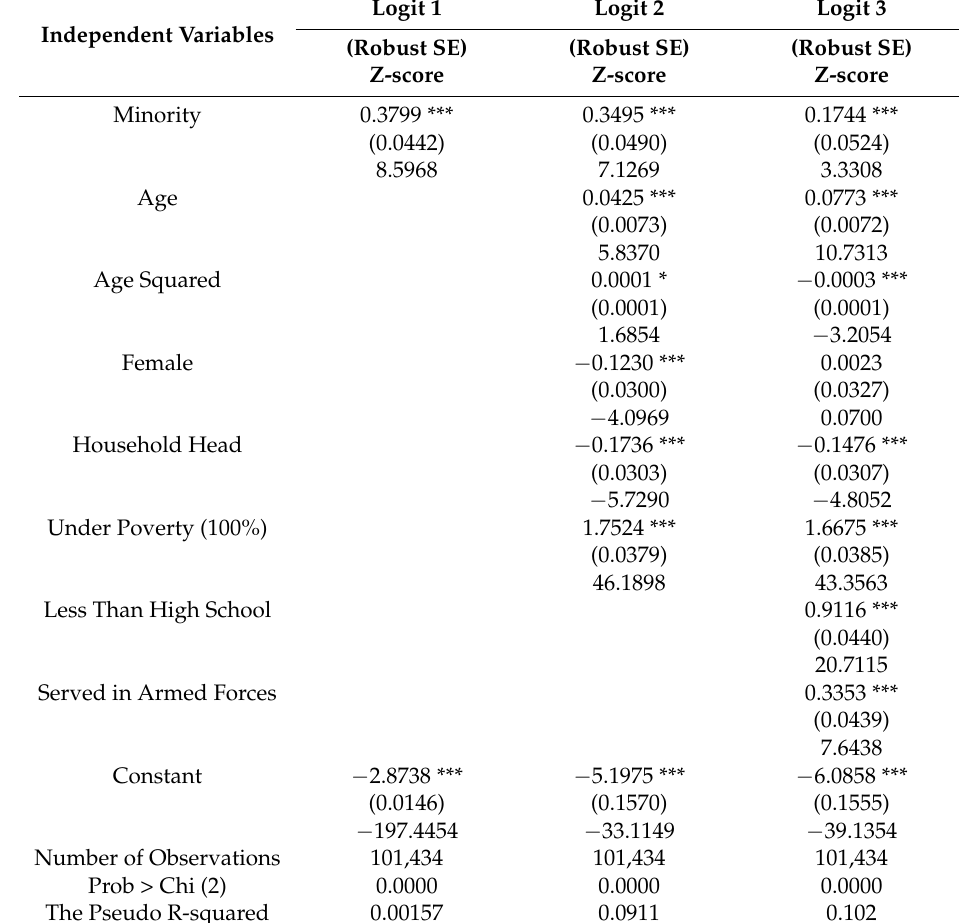
Table A3. Logit model on probability of limited working conditions, Ages 16–65 (Integrated Public Use Microdata Series-USA (IPUMS-USA),